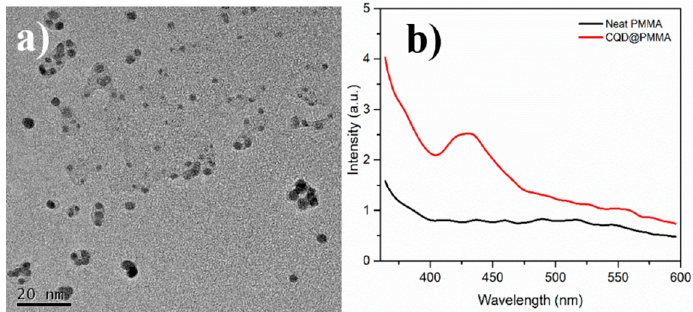
Figure 2. ( a ) TEM image of prepared carbon quantum dots (CQDs), and ( b ) fluorescence emission of